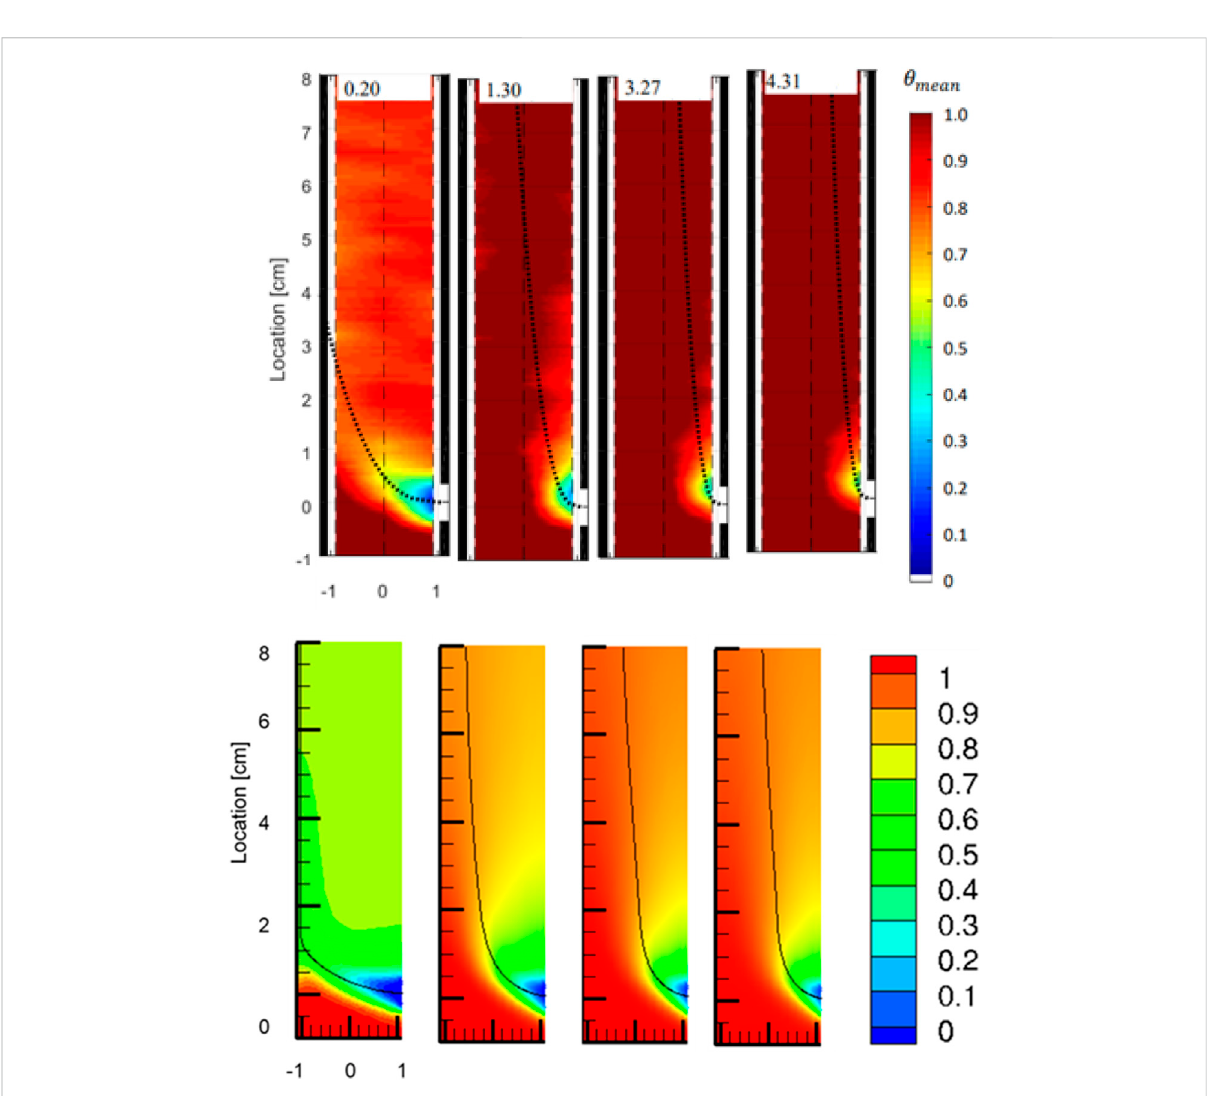
FIGURE 3 Normalized mean temperature for various momentum ratios. Top row: results from experiments, predicted jet trajectories displayed with dotted black lines. Bottom row: results from simulations (cases 1 – 4 from left to right), jet trajectories displayed with solid black